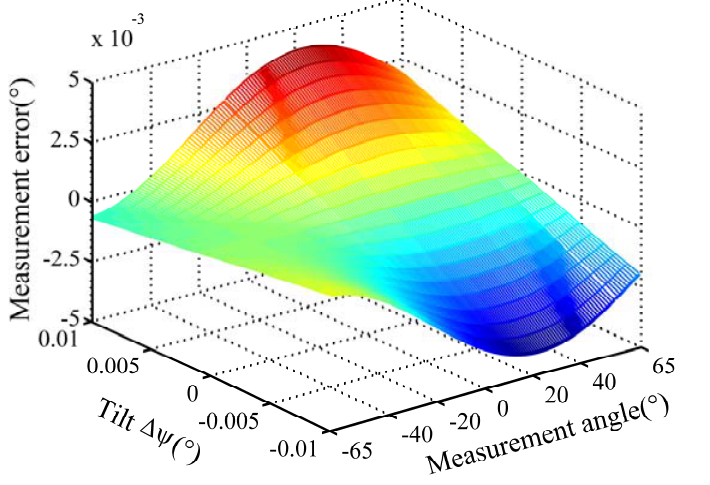
Figure 6. Measurement error caused by tilt deviation.